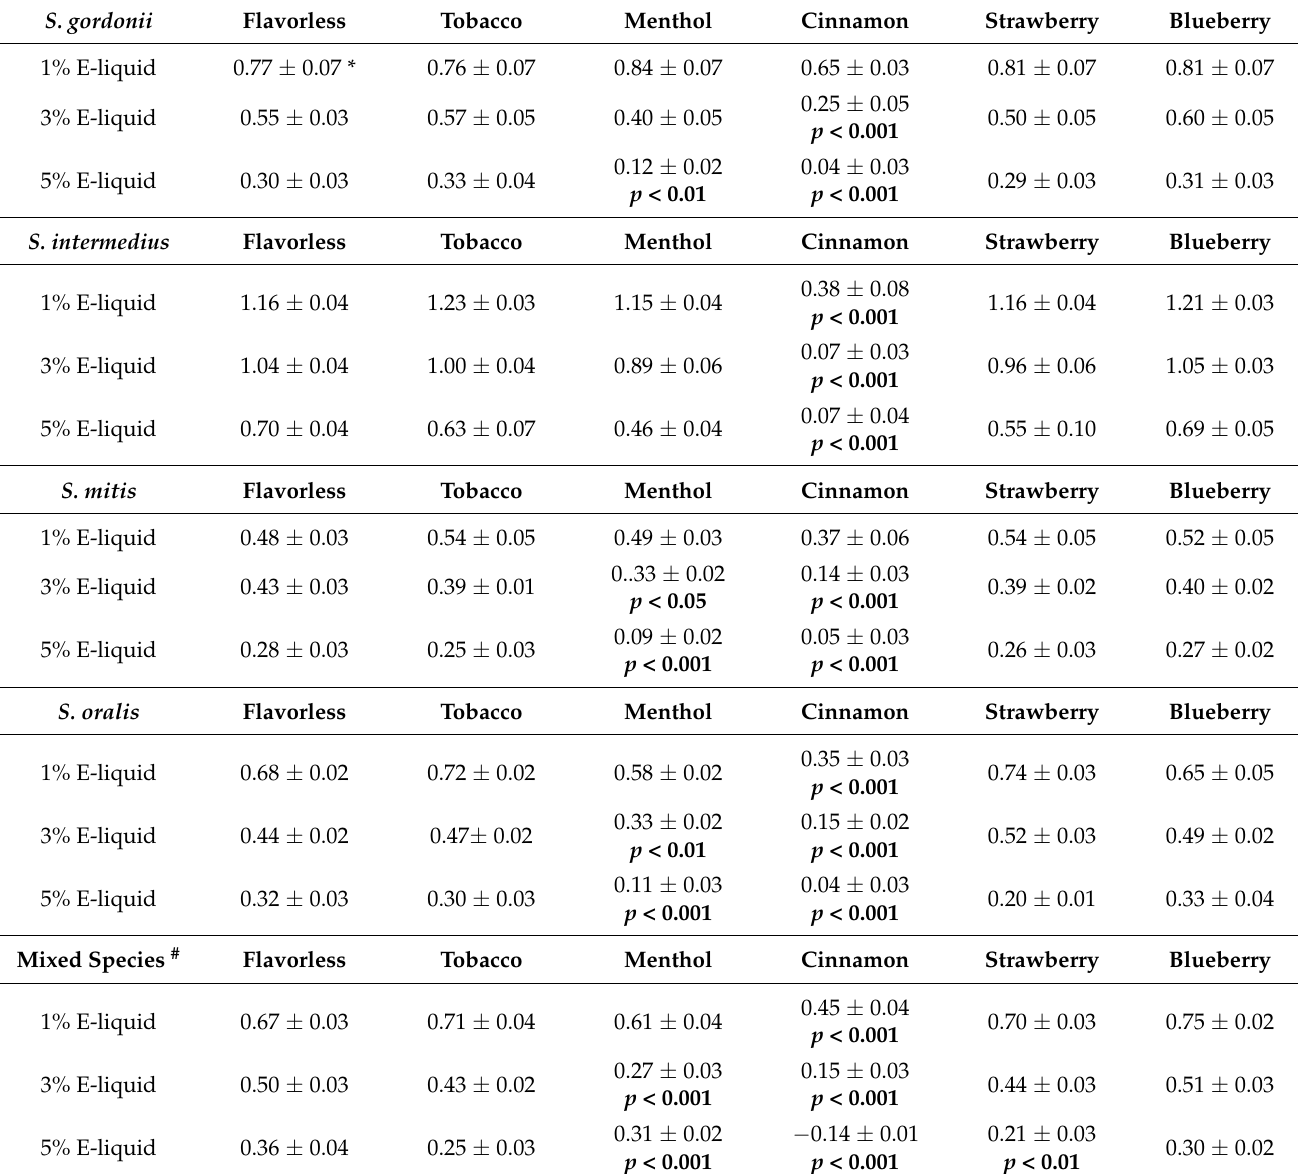
Table 2. Comparison of Absorbance Readings of Flavorless E-liquid vs. each of the Flavored E-liquids. S.